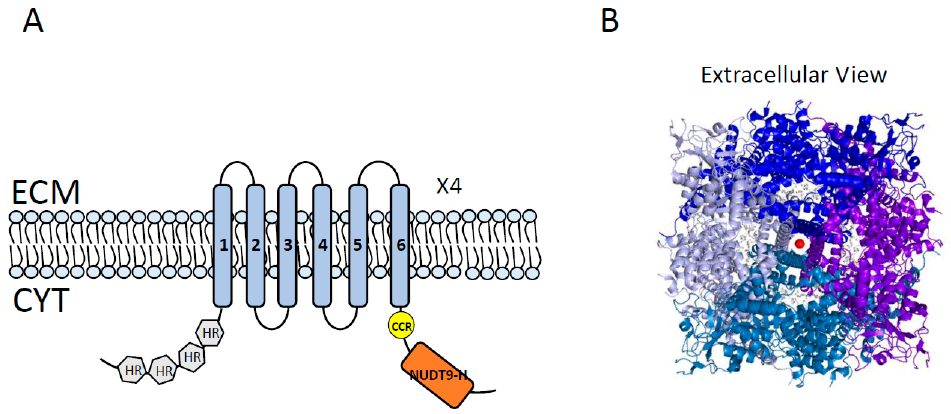
Figure 5. Topology diagram and 3D structure of TRPM2. ( A ) Topology of TRPM2 showing its 6 transmembrane segments (TMS), a channel pore between TMS 5 and 6, and cytoplasmic N- and C-termini. N-terminal harbors 4 TRPM homology domains (shown in gray). C-terminal has a short coiled-coil region (CCR, shown in yellow) followed by the NUDT9H domain (shown in orange) which is the homolog of soluble mitochondrial ADPRase NUDT9. A functional TRPM2 is composed of four homotetramers TRPM2 (x4) and requires binding and hydrolysis of ADP-ribose (ADPR) by NUDT9-H. ECM = extracellular milieu; CYT = cytoplasm. ( B ) Overall domain architecture of TRPM2 (Protein Data Bank [PDB] code 6CO7), showing the extracellular view of four units of TRPM2 surrounding the channel pore (shown in different colors: blue, purple, marine, and light blue, “—” in a clockwise direction).